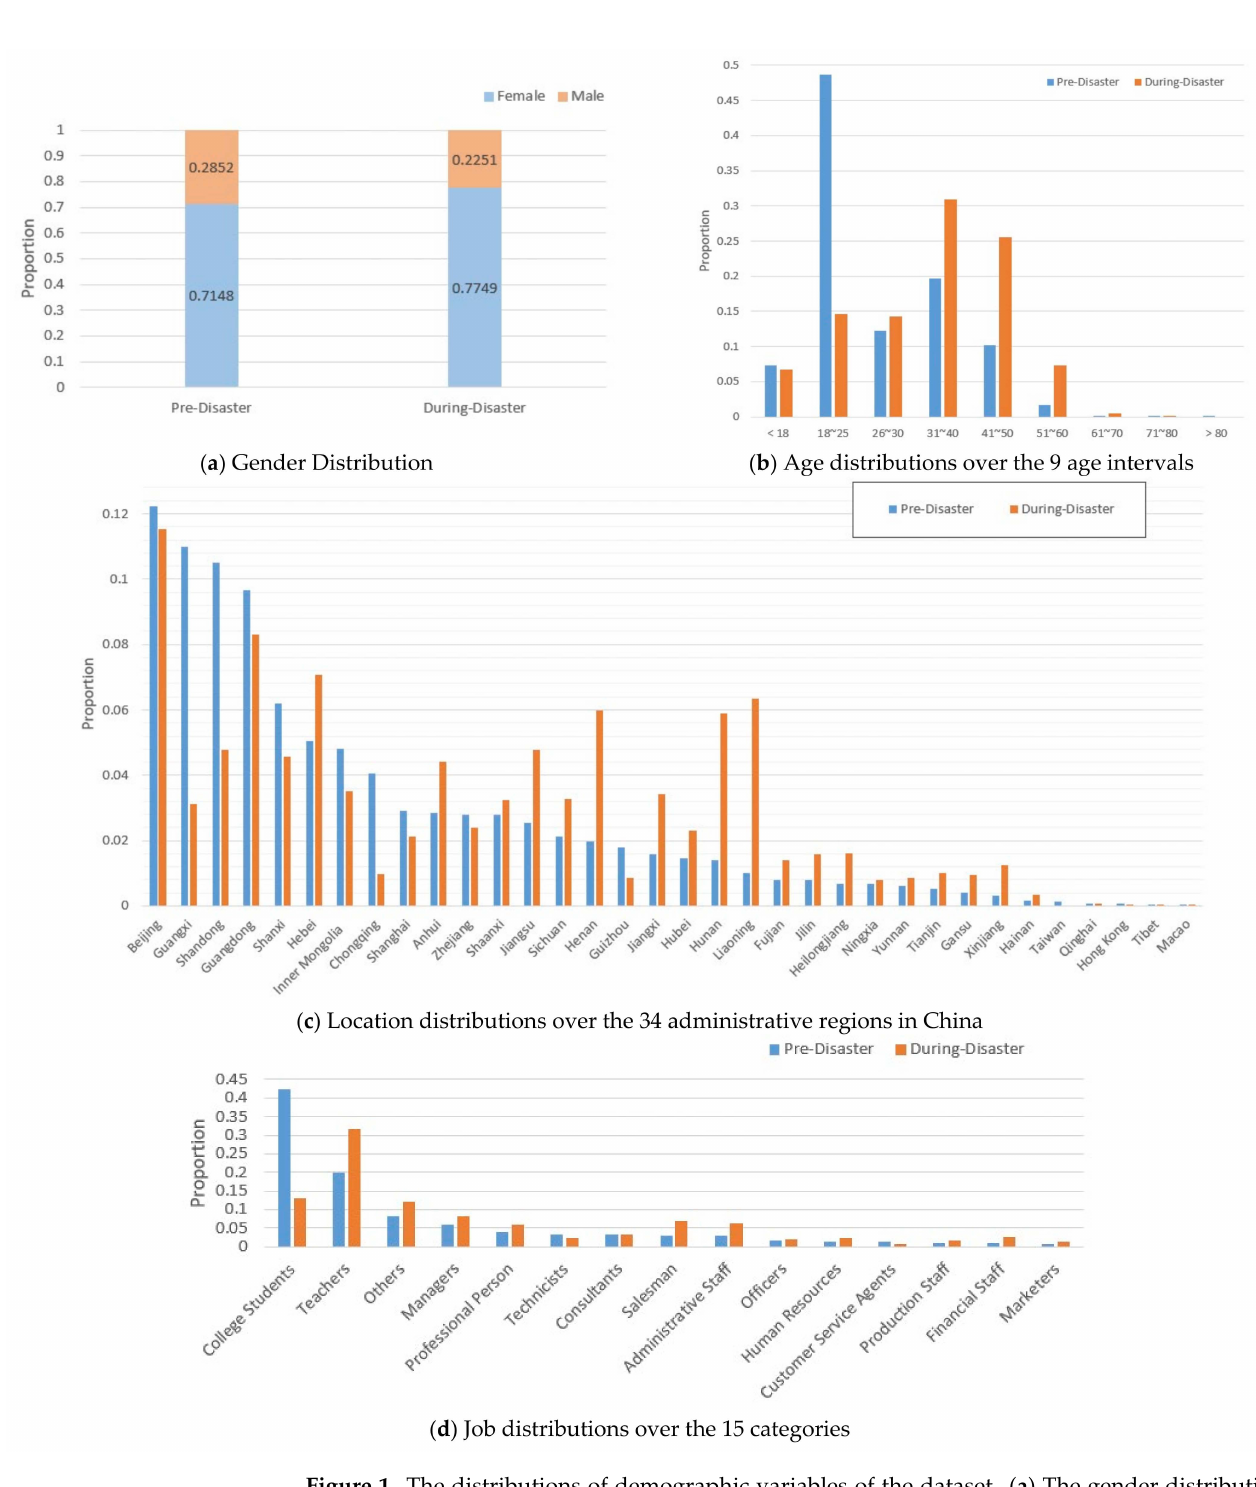
Figure 1. The distributions of demographic variables of the dataset. ( a ) The gender distribution, represented by the proportions of female and male subjects in Pre-/During-Disaster, respectively. ( b ) The age distribution, represented by the proportions of the 9 age intervals in each period. ( c ) The distributions of the subjects’ locations, covering the 34 administrative regions in China. ( d ) The distributions of the subjects’ jobs, covering the 15 major categories. Note that for each period (Pre-/During-Disaster), the distributed proportions of a given demographic variable added up to